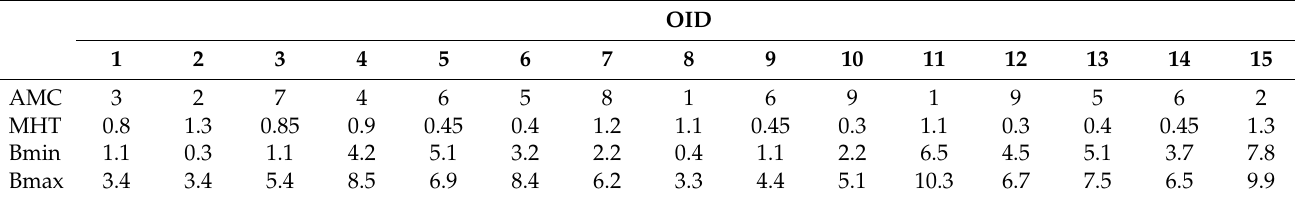
Table 5. Optimal assignment of production orders to matrix cells and their lower and upper time limits as input parameters if there is a routing problem in the matrix grid (OID = production order ID. AMC = assigned matrix cell ID. MHT = material handling time of the production order at the matrix cell. BMin = beginning time lower limit. BMax = beginning time upper limit).